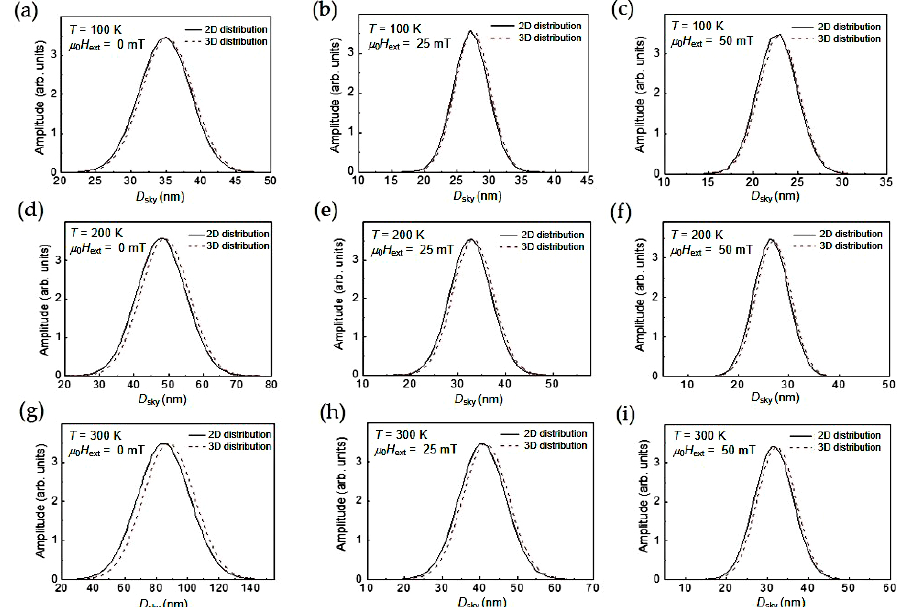
Figure 2. Comparisons between the 2D (solid black lines) and 3D (dashed red lines) skyrmion diameters distributions at: ( a ) T = 100 K and µ 0 H ext = 0 mT; ( b ) T = 100 K and µ 0 H ext = 25 mT; ( c ) T = 100 K and μ 0 H ext = 50 mT; ( d ) T = 200 K and μ 0 H ext = 0 mT; ( e ) T = 200 K and μ 0 H ext = 25 mT; ( f ) T = 200 K and μ 0 H ext = 50 mT; ( g ) T = 300 K and μ 0 H ext = 0 mT; ( h ) T = 300 K and μ 0 H ext = 25 mT; ( i ) T = 300 K and μ 0 H ext = 50 mT. (The 3D skyrmion diameters distributions at T = 100 K, 200 K and 300 K and μ 0 H ext = 25 mT are the analytical distributions shown in Figure 3 of [13]).